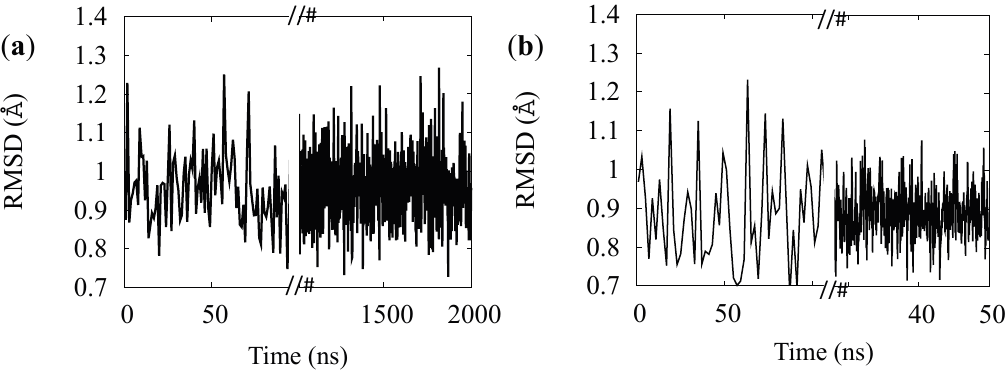
Figure 4. RMSD of the simulation of the BR ( a ) and for MR ( b ) rest states.